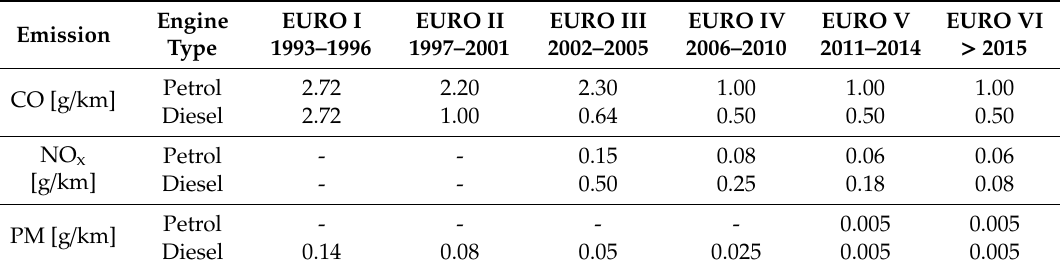
Table 6. Limits for exhaust emissions of new vehicles sold in the European Union and EEA member states. Values used in the calculations.